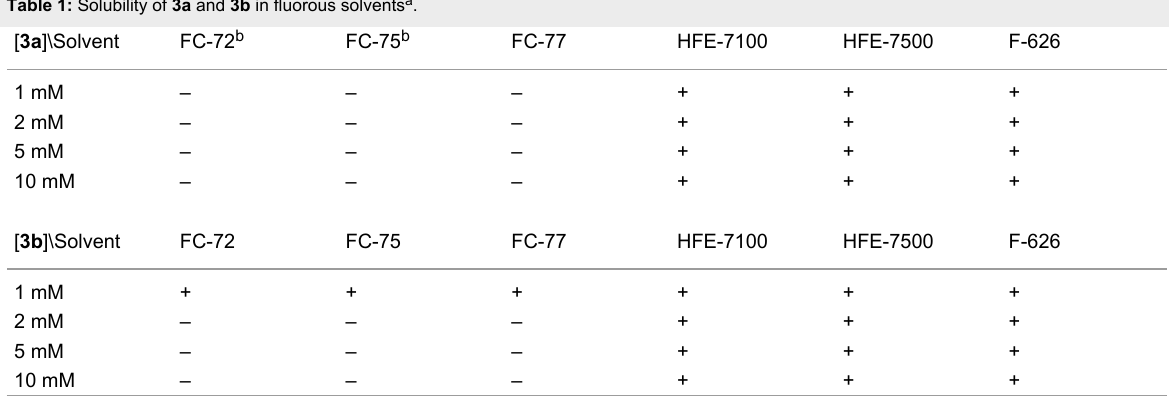
Table 1: Solubility of 3a and 3b in fluorous solvents a .